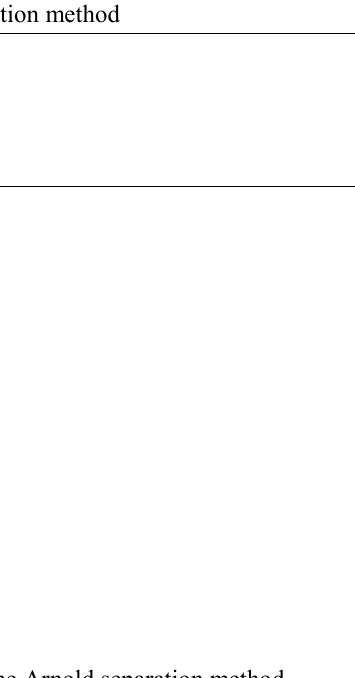
Fig. 3 The hydrograph of the streamflow and the baseflow from the Arnold separation